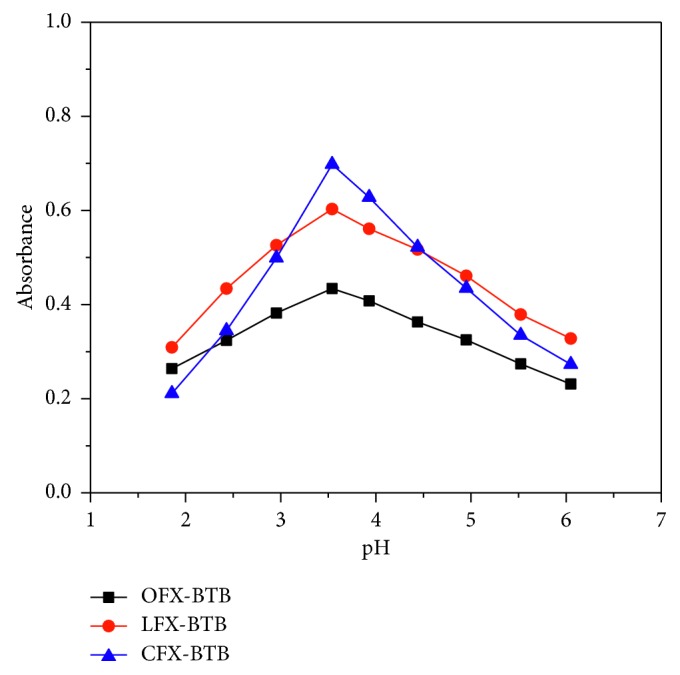
Effect of pH on the absorbances of 10 μg/mL of OFX, LFX, and CFX.